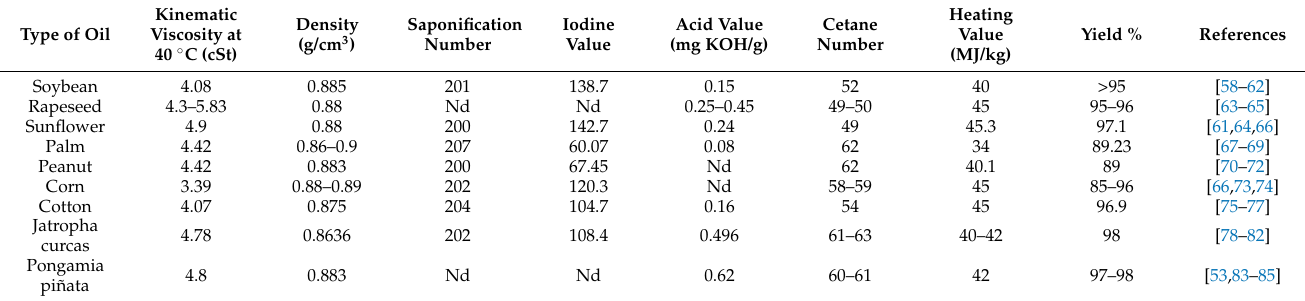
Table 1. Physiochemical Properties and Yield of Biodiesel from Different